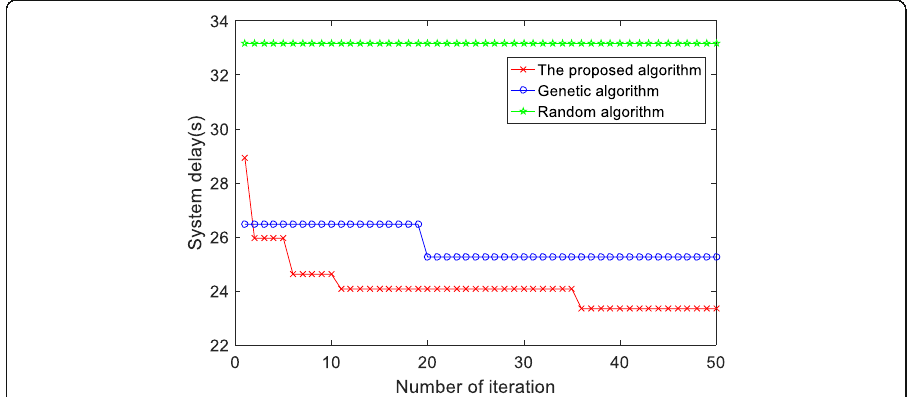
Fig. 7 The total system delay under different